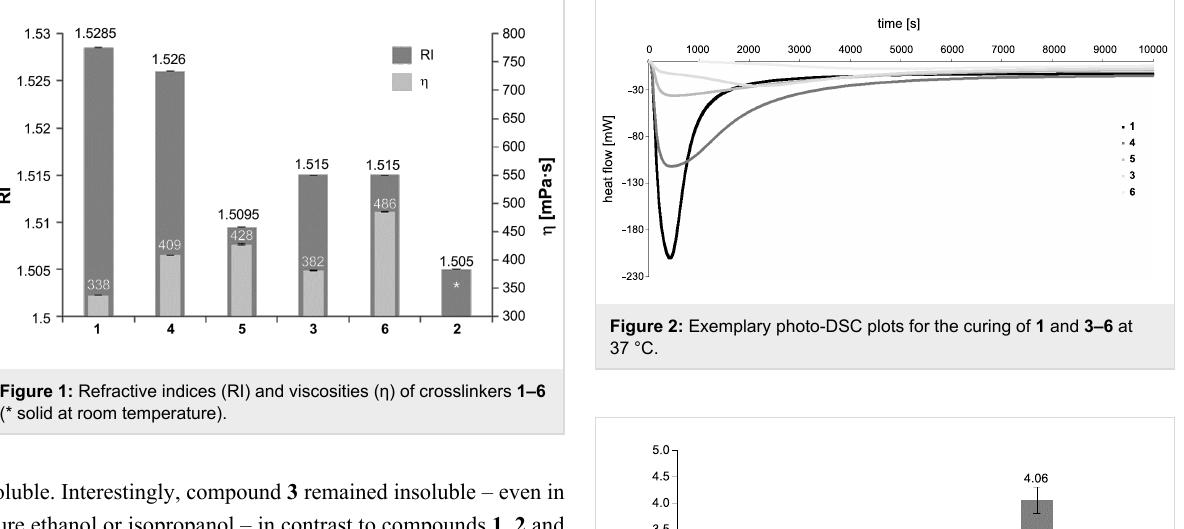
soluble. Interestingly, compound 3 remained insoluble – even in pure ethanol or isopropanol – in contrast to compounds 1 , 2 and 4–6 . Overall, a broad solubility spectrum was found (Table 1).